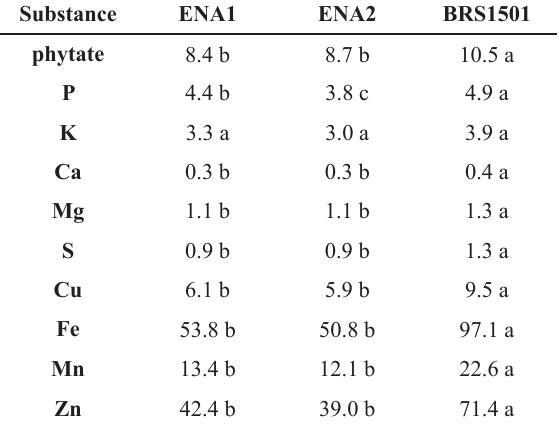
Phytate content (g kg -1 ) and mineral (g kg -1 ) content in grains of the three pearl millets